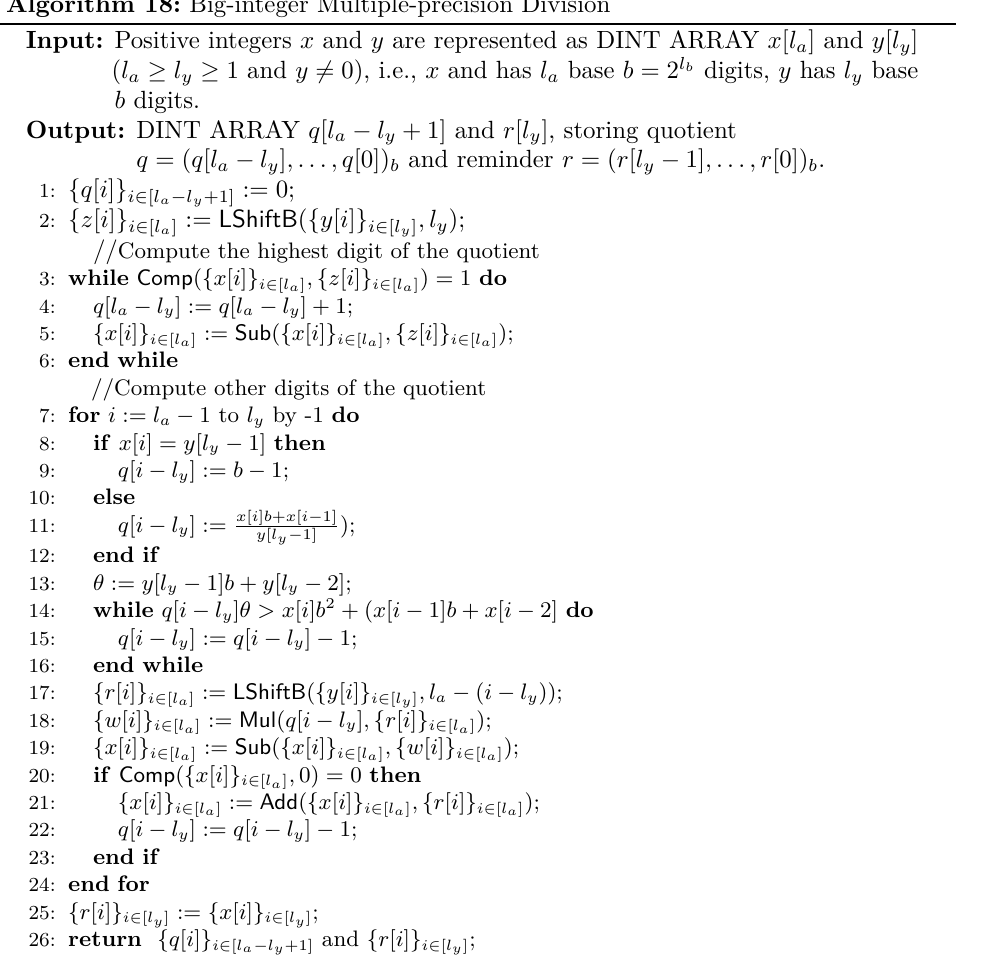
Algorithm 18: Big-integer Multiple-precision